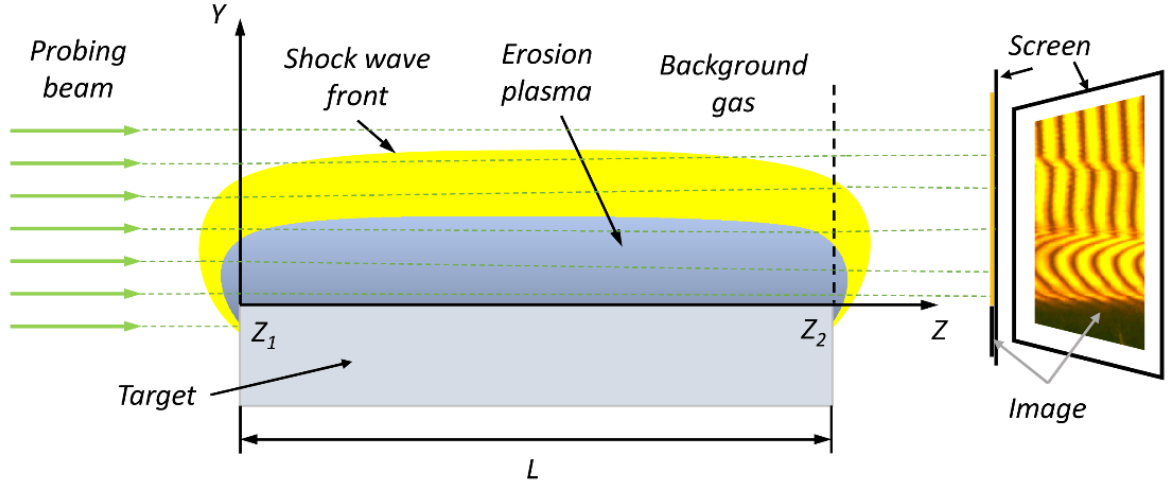
Figure 3. The probing beam passing through the inhomogeneity.